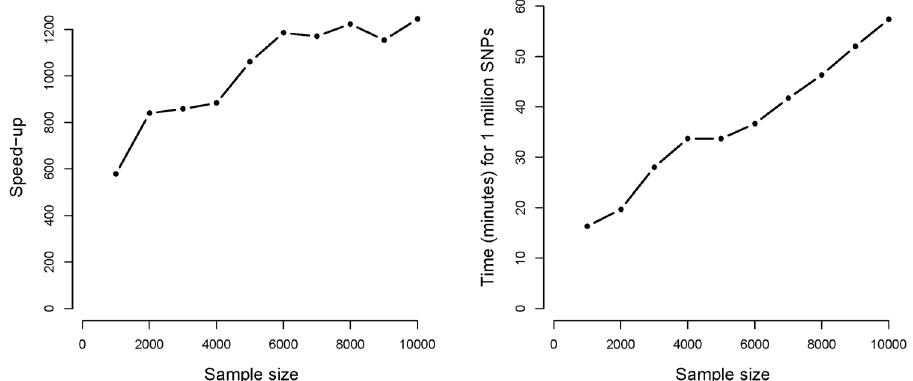
Figure 1. Speed-up compared to the lmer function in R. Results based on the simulated data for 1000 SNPs, 4 time points and 3 covariates. Performed on a 64-bit Windows running on a laptop with CPU @ 2.3 GHz and 6 GB